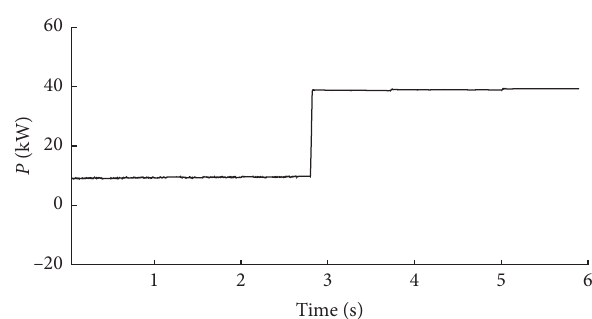
Figure 8: Output power of the ESS (output power increases from 10kW to 40kW).